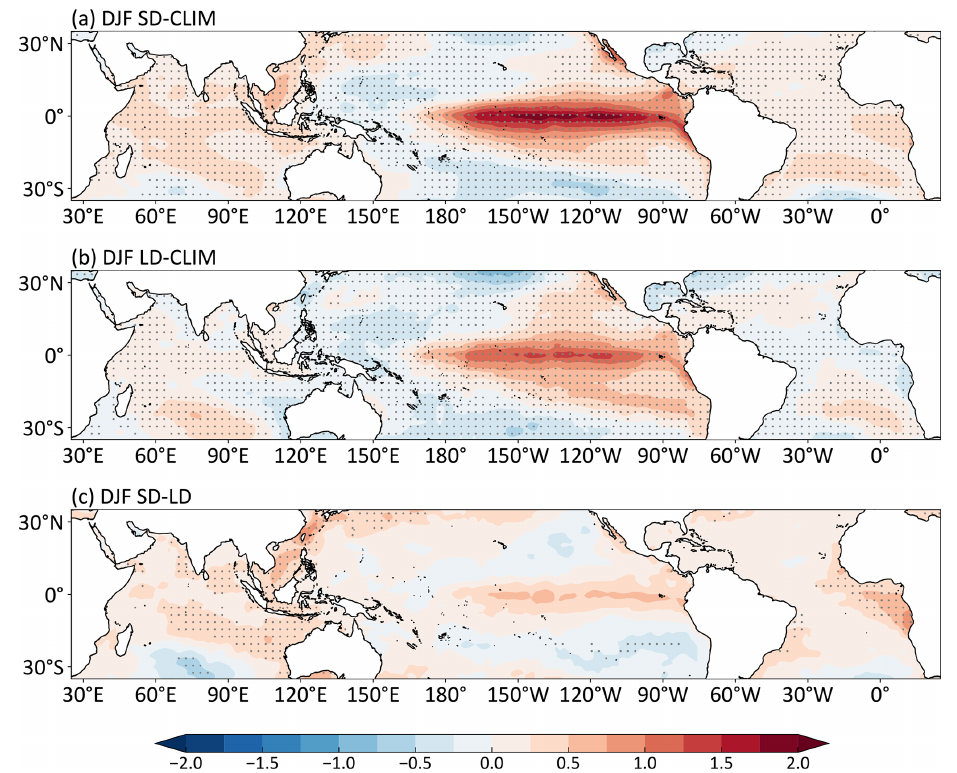
Figure 3. Composite differences in DJF mean SST ( ◦ C) between SD (a) or LD (b) El Niño events and climatological mean over 1870–2017 and between SD and LD (c) El Niño events. Differences that are statistically significant at 95% from a two-tailed t test are stippled. Table 1. Experimental